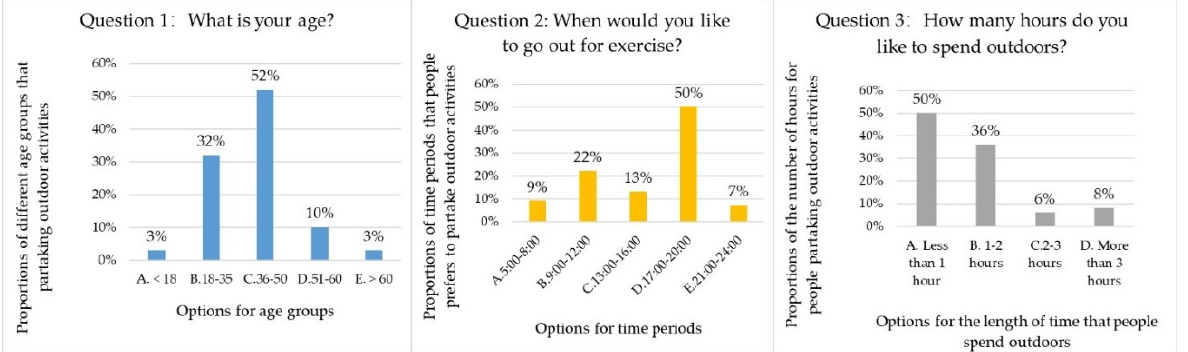
Figure 7. The survey results for Questions 1, 2 and 3 of the questionnaires.